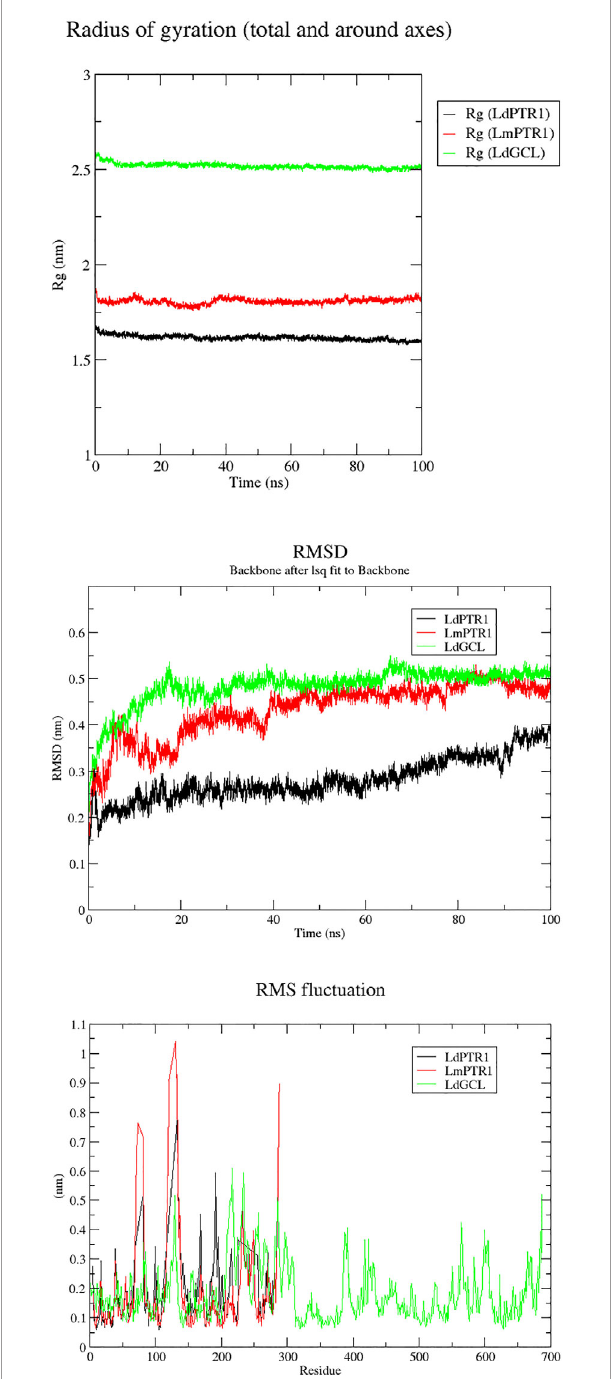
FIGURE 7 | Rg , RMSDs and RMSFs plots for the protein – hardwickiic acid complex MDs undertaken in 100 ns: (A) Rg plots of the three proteins in complex with hardwickiic acid. (B) The plot of RMSDs over 100 ns for the three complexes. (C) RMS Fluctuations (RMSFs) of amino acid residues pertaining to the three proteins in complex with hardwickiic acid. Ld PTR1, Lm PTR1, and Ld GCL complexes are illustrated as black, red, and green colors,